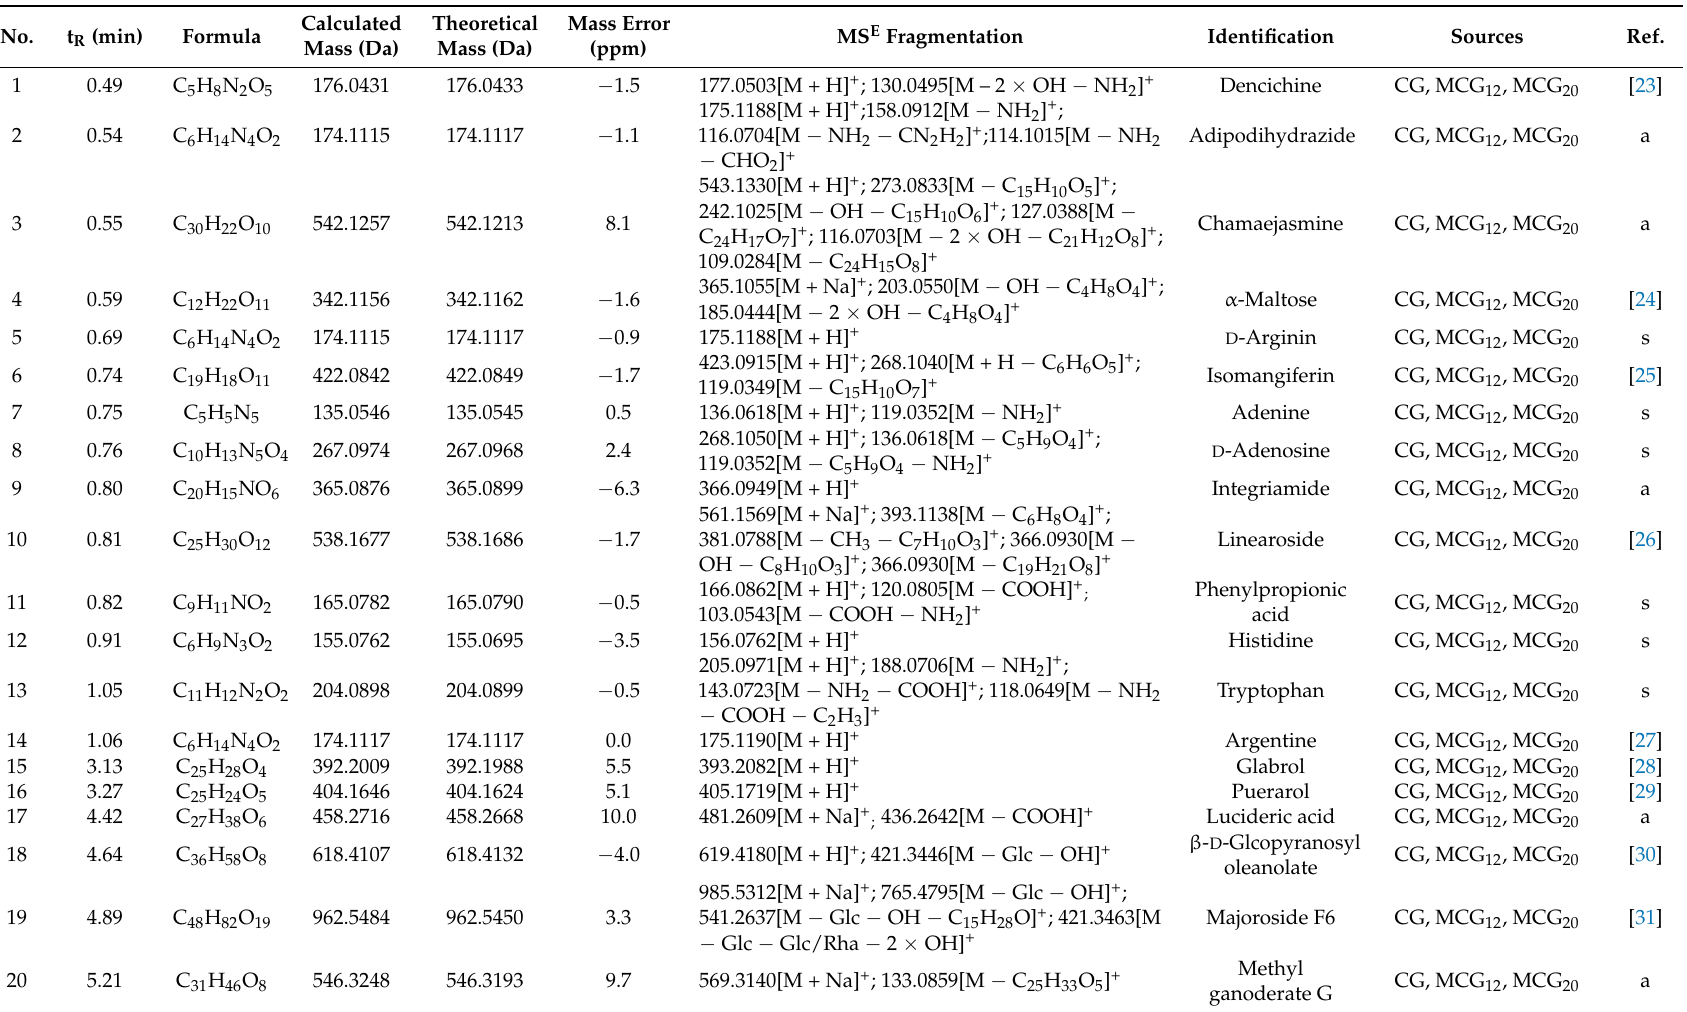
Table 2. Compounds identified from MCG and CG by UPLC-QTOF-MS E